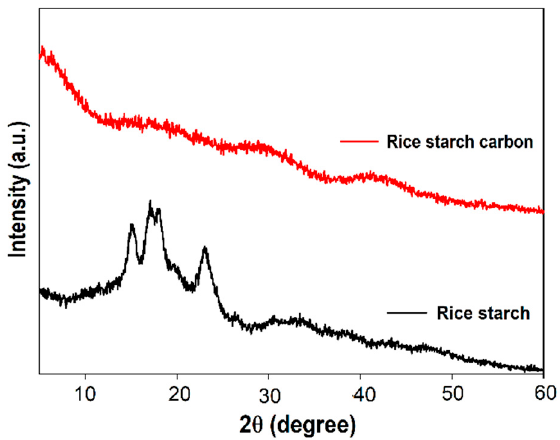
Figure 7. XRD analysis before and after carbonization.